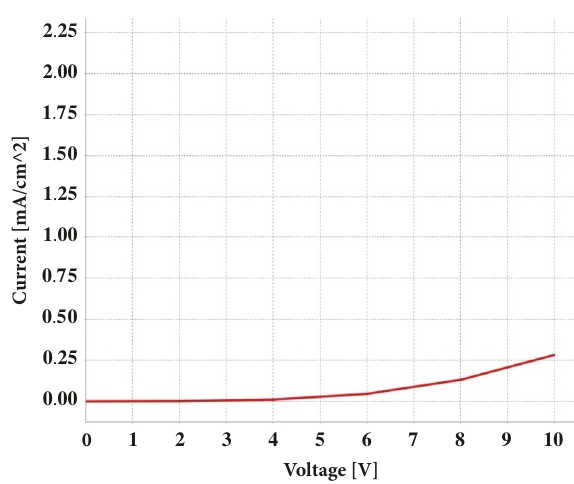
Figure 16: JV plot of device B2.